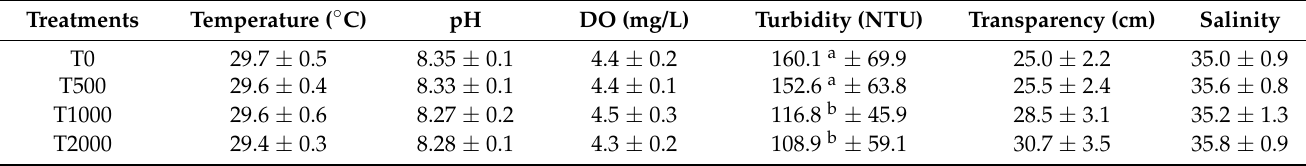
Table 1. Mean ( ± SD) of temperature, pH, dissolved oxygen (OD), turbidity, transparency, and salinity for the different treatments throughout the experimental period of 90 days. T0: L. vannamei monoculture (100 shrimp/m 2 ); T500: (100 shrimp/m 2 and 500 g/m 2 macroalgae G. birdiae ); T1000: (100 shrimp/m 2 and 1000 g/m 2 of the macroalgae G. birdiae ); T2000: (100 shrimp/m 2 and 2000 g/m 2 of the macroalgae G. birdiae